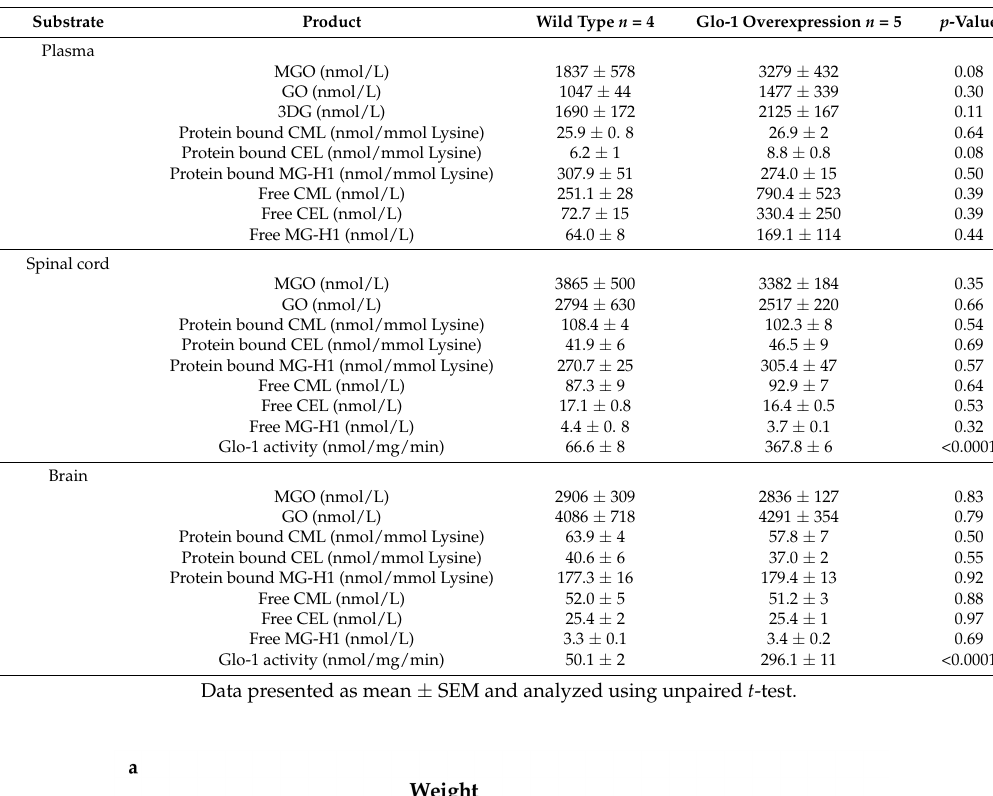
Table 3. Dicarbonyl and AGE levels in the plasma and central nervous system of full body Glo-1 overexpression mice and wild type littermates after EAE.